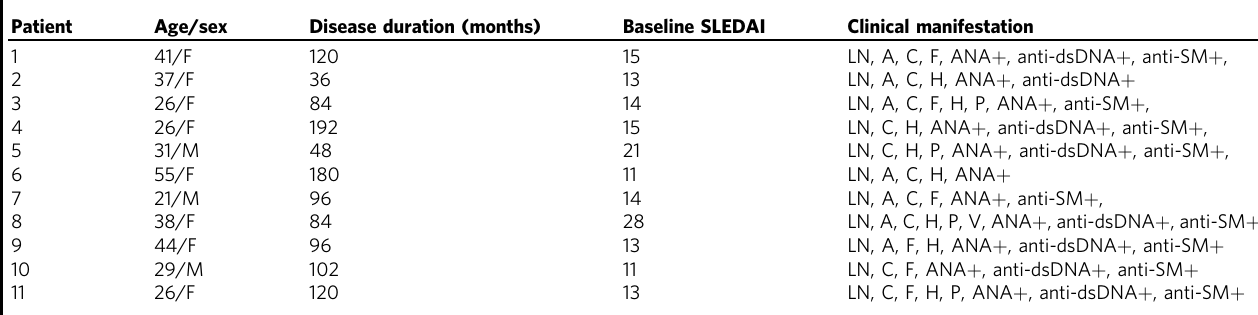
Table 1 Patients ’ baseline clinical